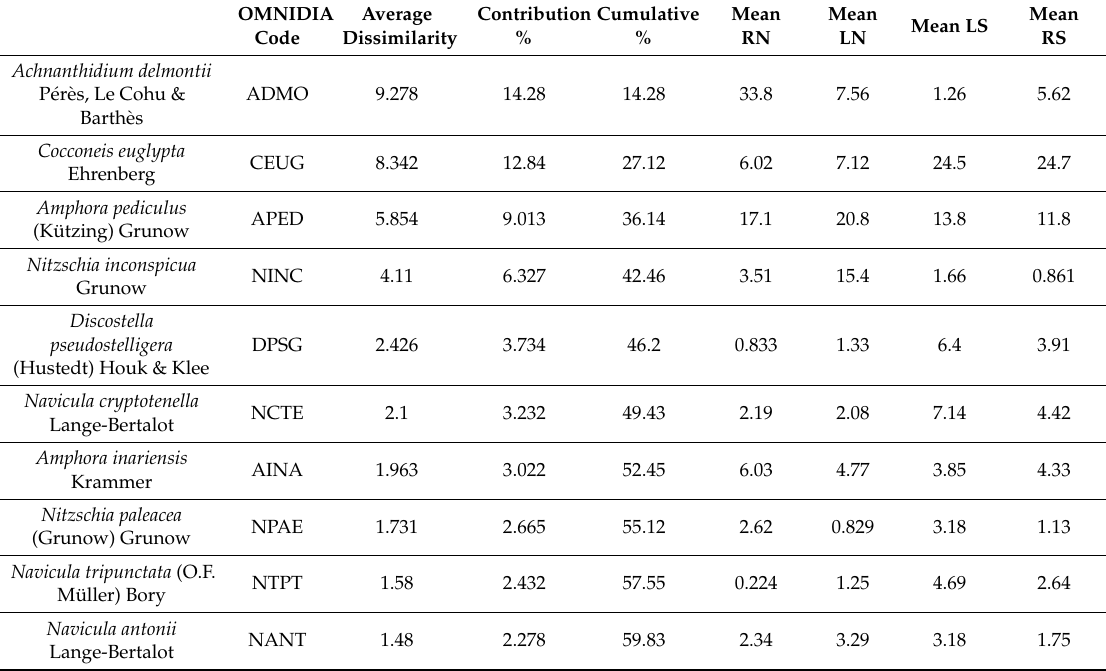
Figure 4. ( A ) Non-metric multidimensional scaling (NMDS) with Bray-Curtis dissimilarity index illustrating the separation of samples based on the relative abundances of species, Markings: green cross—samples from upstream, right bank (RN), orange filled square—samples from upstream, left bank (LN), brown filled triangle—samples from downstream, right bank (RS), black dot—samples from downstream, left bank (LS). ( B ) Boxplot illustrating values of Specific Pollution Sensitivity Index (IPS). The green line shows the good / moderate boundary value of the index. Table 2. List of species contributing most to the separation of samples according to sites and banks, as shown by the similarity of percentage